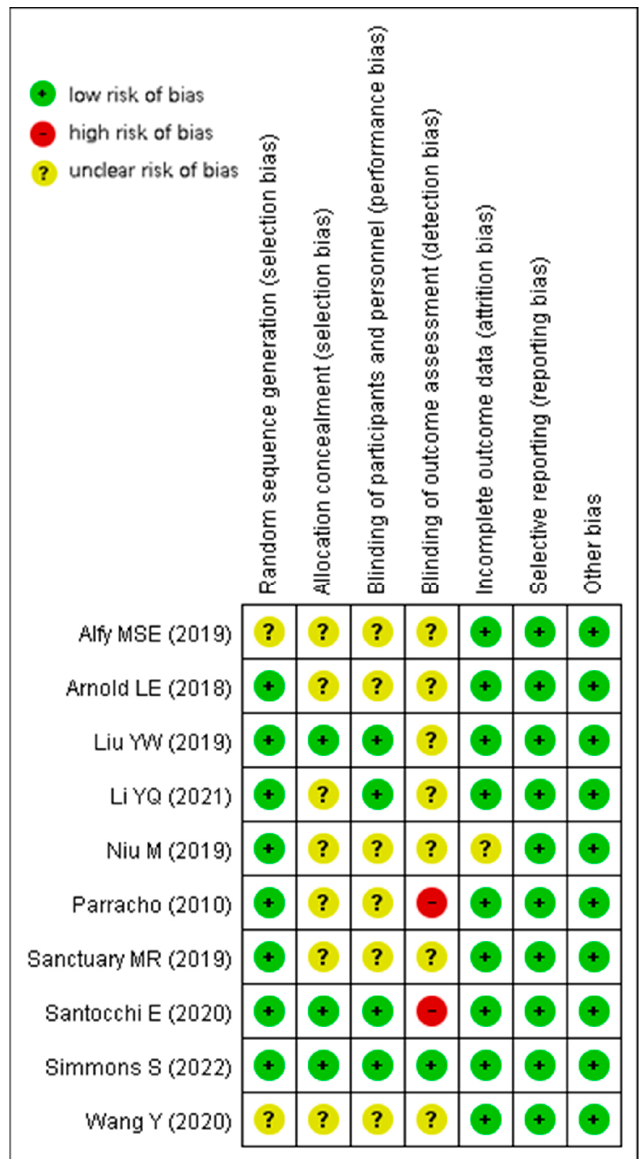
Figure 3. Risk of bias summary for RCTs and crossover controlled trials [23–32].